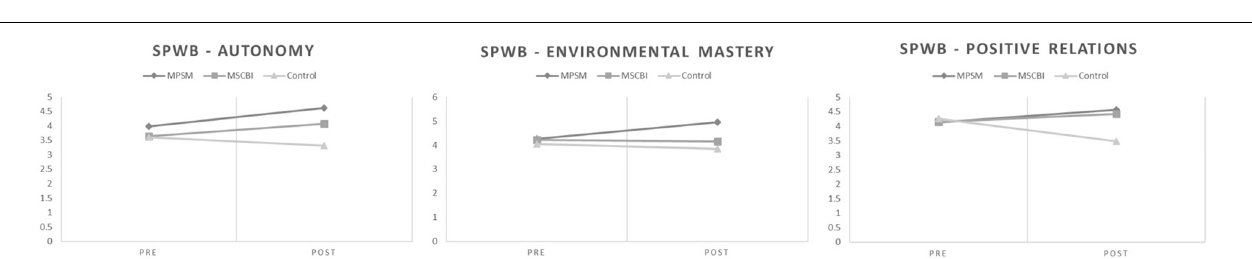
FIGURE 1 | Means estimated for the MBSR group, MPSM group, and control group on pre-intervention and post-intervention time points, for mindfulness dimensions with statistically significant interaction effect.